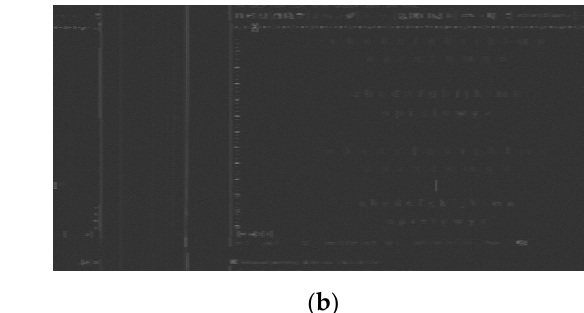
Figure 25. The normalized values of the adopted measures (method I, II and III) calculated in domain of image line length d ∆ for the accuracy ∆ = 0.1 (for the original image shown in Figure 7d).